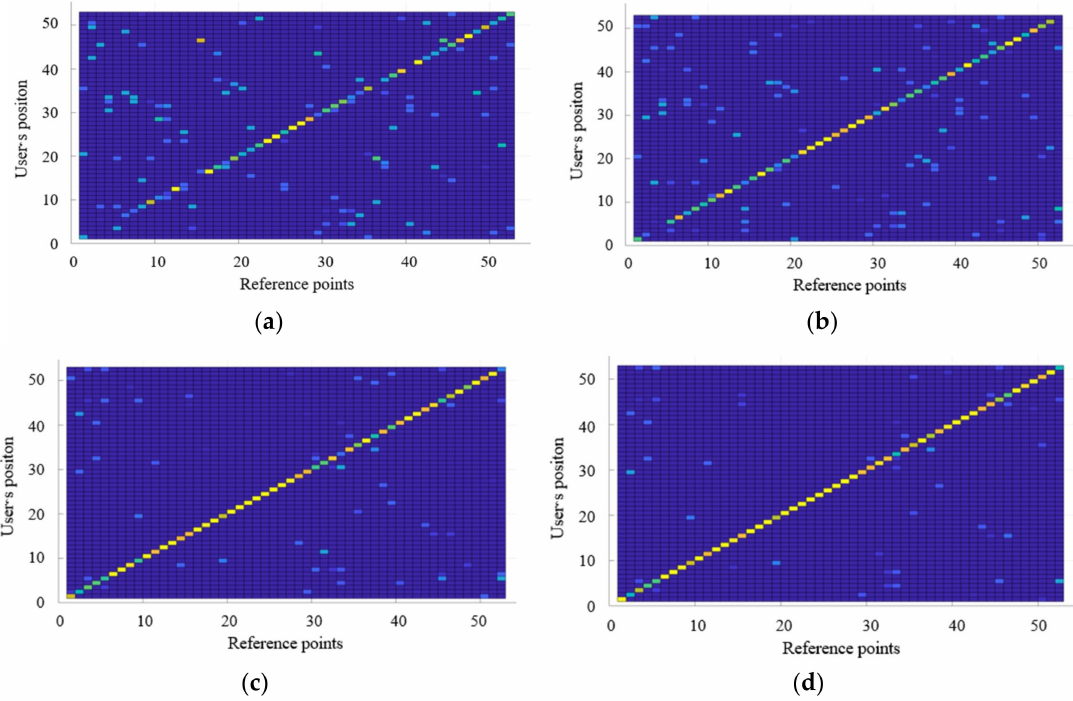
Figure 8. Analysis of positioning accuracy of the proposed radio map, according to the number of geomagnetic signal acquisitions: ( a ) Initial radio map (one acquisition); ( b ) three acquisitions; ( c ) six acquisitions; ( d ) positioning accuracy after applying the proposed algorithm (eight